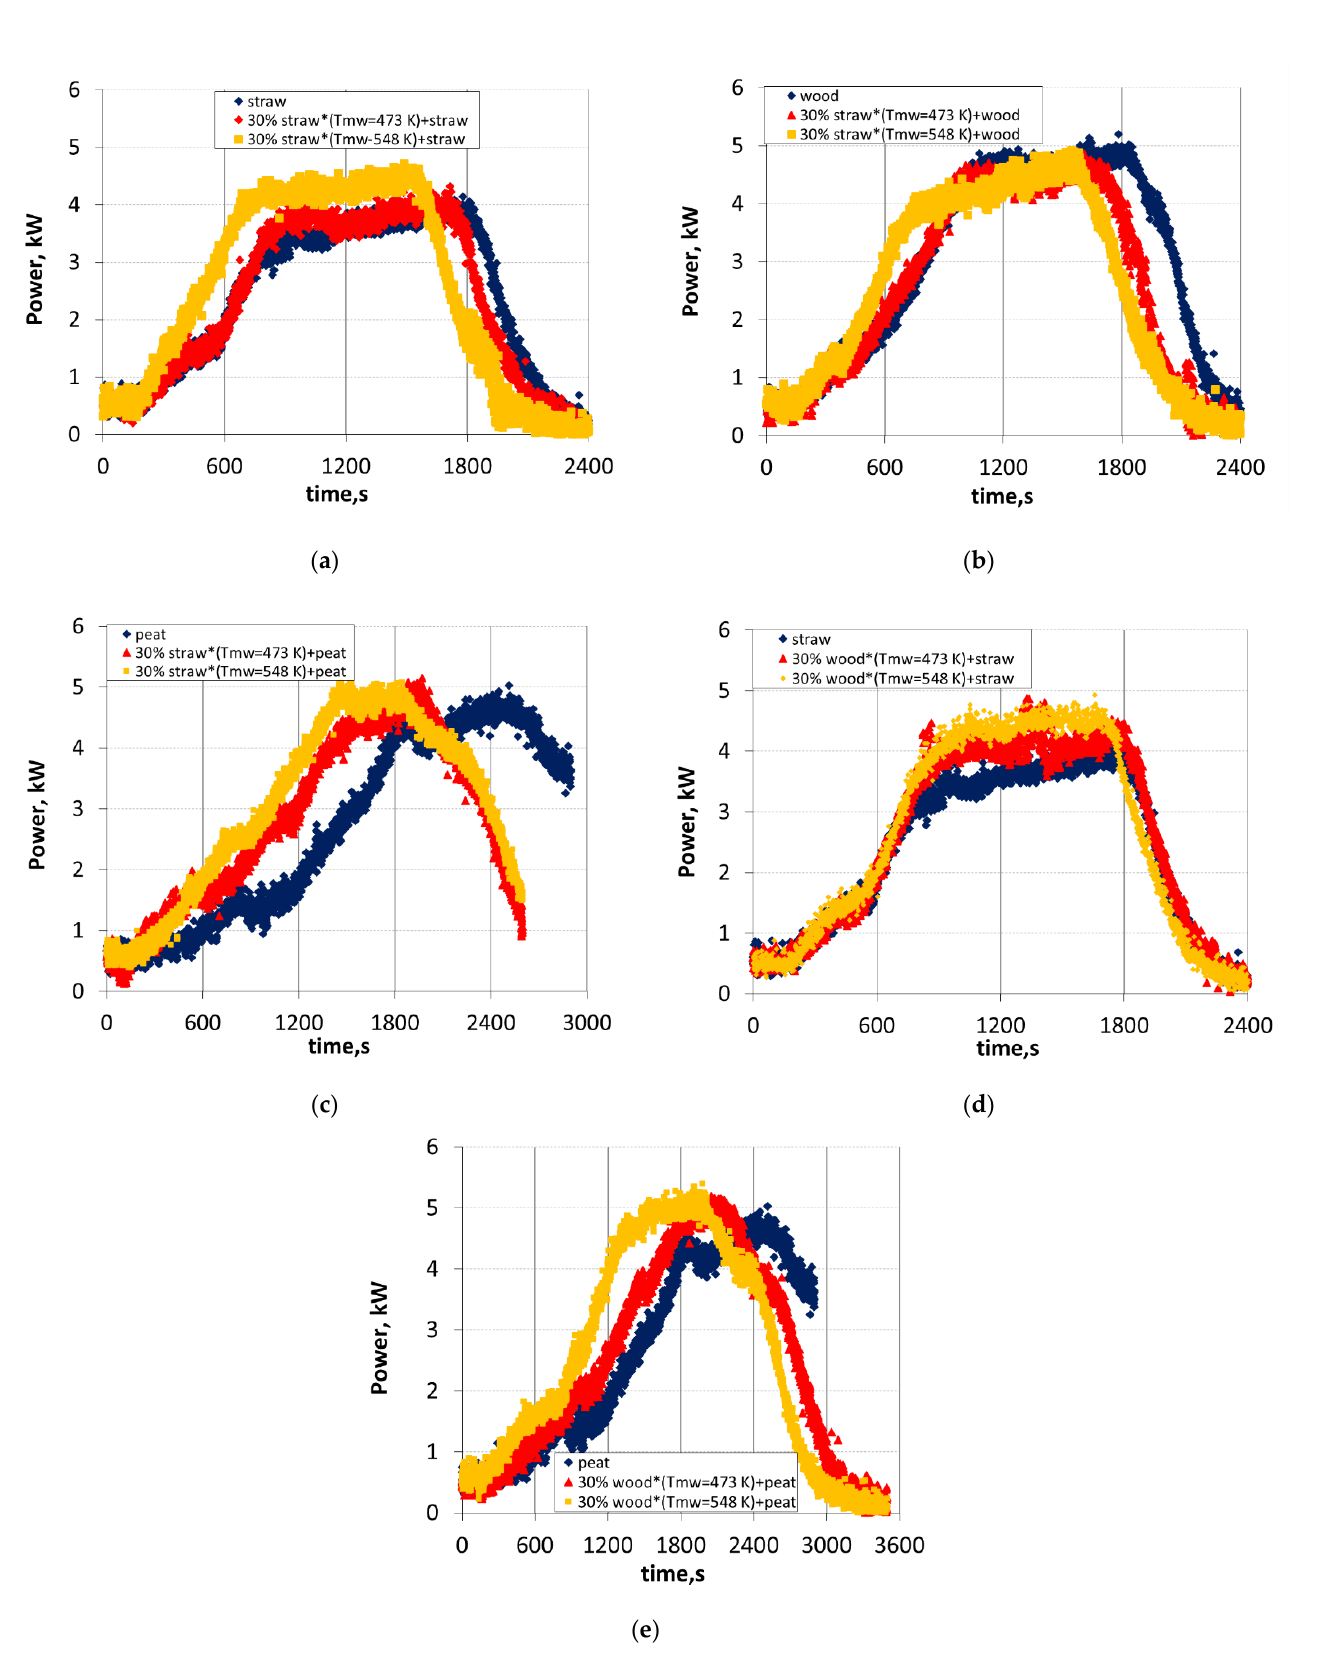
Figure 9. The heat power of the device for different types ( a – e ) of selectively pre-treated biomass